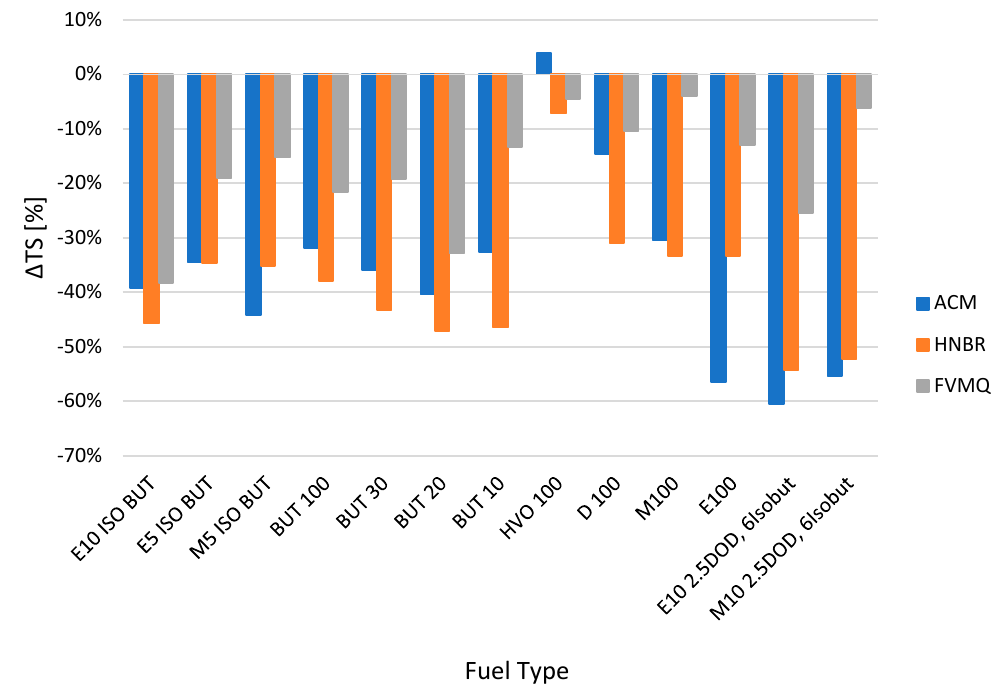
Figure 4. Change in tensile strength ∆ TS for different elastomer O-rings and fuels after exposure for a time interval of 2998 h.